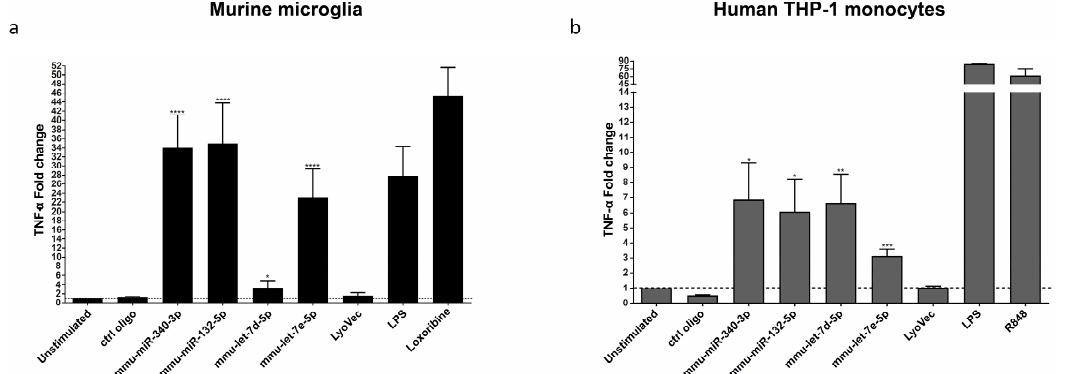
Figure 3. miR-340-3p and miR-132-5p induce TNF release from murine microglia and human THP-1 cell-derived monocytes. Murine microglia from C57BL/6 mice ( a ) and human THP-1-derived monocytes ( b ) were incubated with 10 µg/mL of the indicated miRNAs for 24 h. Loxoribine (TLR7), resiquimode (R848; TLR7/8), and lipopolysaccharide (LPS) (TLR4) served as positive controls, while unstimulated condition and LyoVec were used as a negative control. Mutant oligoribonucleotide (ctrl oligo, 10 µg/mL) was used as a further negative control. TNF amounts in supernatants were determined via ELISA and are shown as fold change normalized to unstimulated control. Significances were obtained by Student’s t -Test. (* p < 0.05, ** p < 0.01, *** p < 0.001, **** p < 0.0001; * compared to unstimulated control). Data of n = 3 are represented as mean + s.e.m.